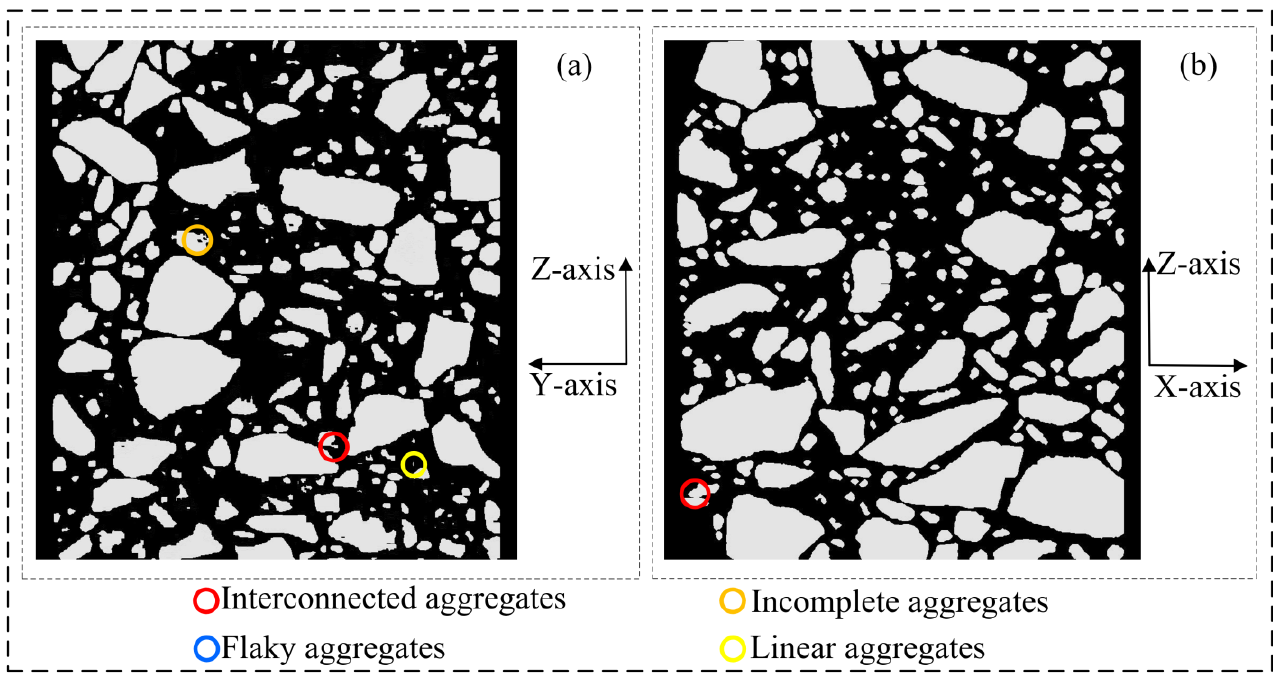
Figure 14. Asphalt concrete 3D voxel model sections (corresponding to Figure 10c): ( a ) YZ section; Materials 2023 , 16 , x FOR PEER REVIEW ( b ) XZ section. ( b ) XZ section.